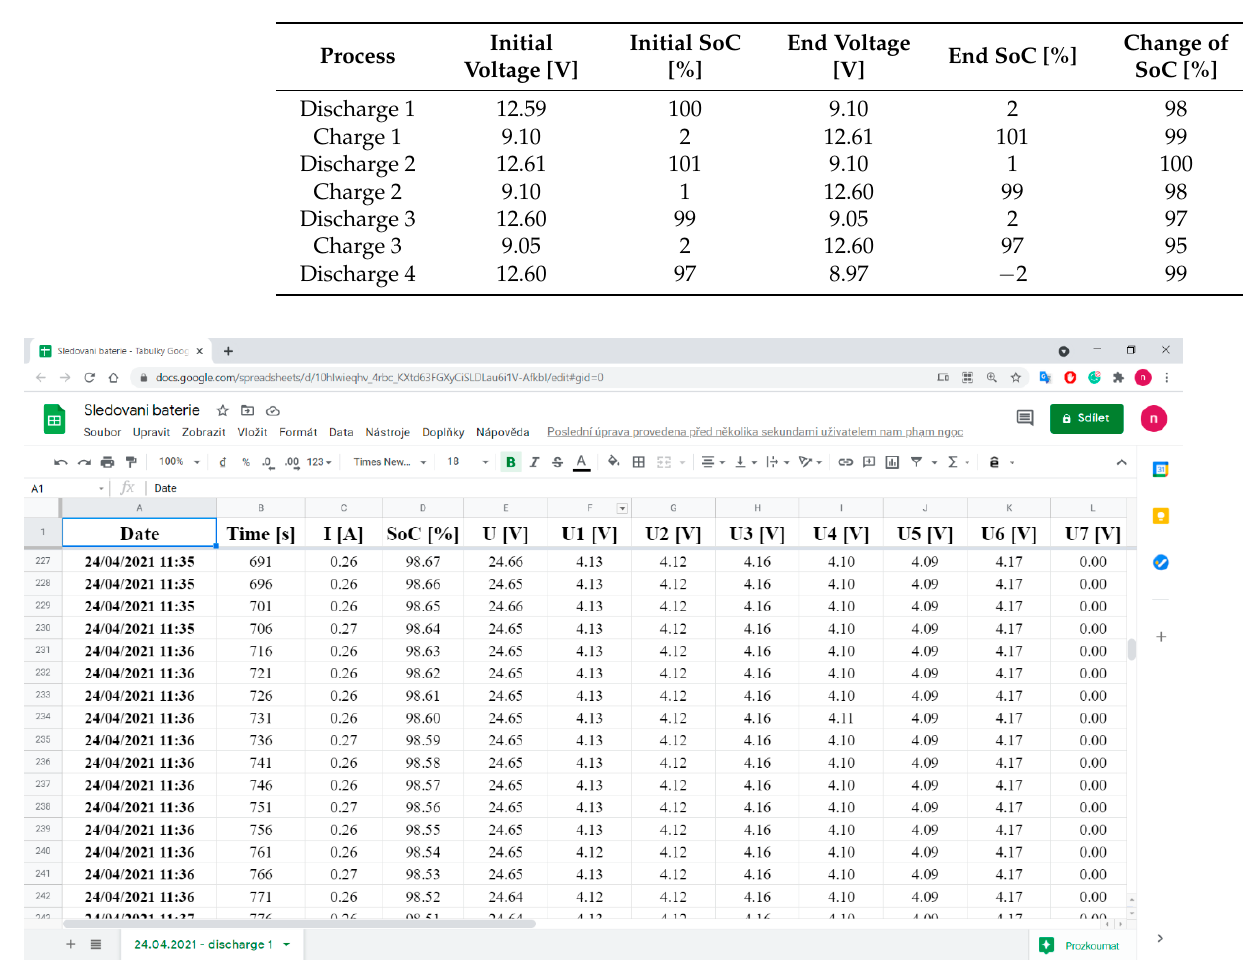
Figure 19. Measurement of Temperature: ( a ) Before Calibration; ( b ) After Calibration. Table 3. Estimated SoC value.